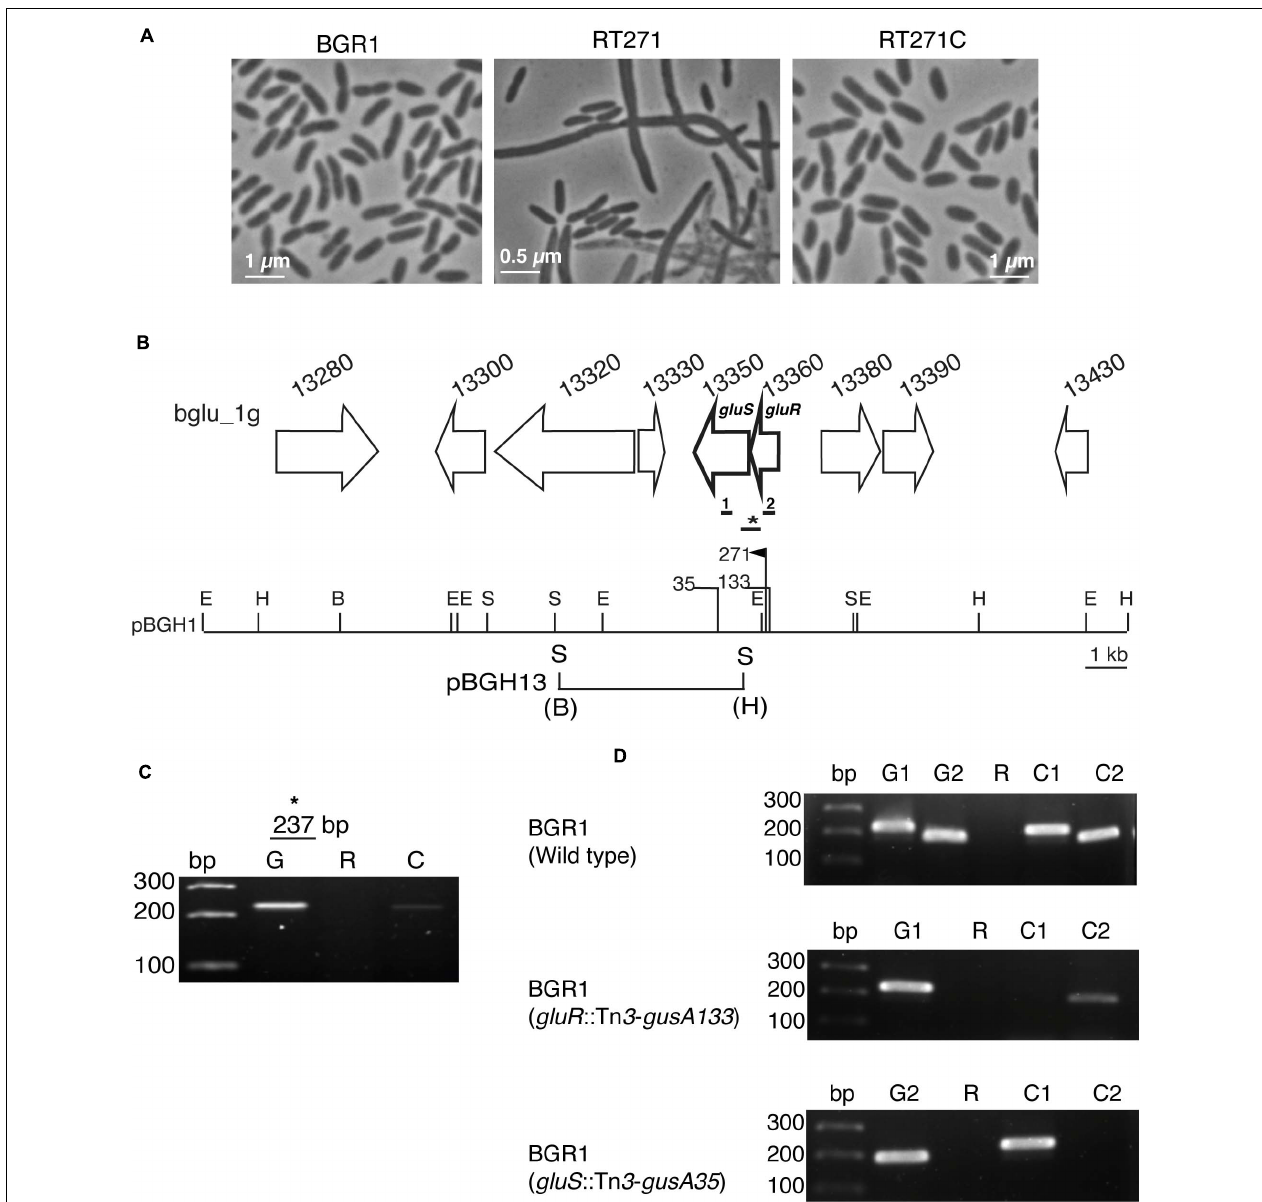
FIGURE 1 | The GluS-GluR two-component system (TCS) of Burkholderia glumae BGR1. (A) Microscopic observation of the cell morphology of BGR1 (wild type), RT271 (BGR1, gluR :mini-Tn 5rescue ), and mutant complemented RT271C (BGR1, gluR :mini-Tn 5rescue carrying pBGH1) strains in Lysogeny Broth (LB) medium. (B) Organization scheme of the GluS sensor kinase and GluR response regulator in pBGH1. Vertical bars above the restriction map indicate the position of the Tn 5 (271) and Tn 3 - gusA insertions (35 and 133). E, Eco RI; H, Hin dIII; B, Bam HI; S, Sac I. The map below pBGH1 represents pBGH13 plasmid of a 6.3-kb fragment containing gluS and gluR genes. (C) RT-PCR analysis showing that gluS and gluR genes are co-transcribed in BGR1. Primers were designed to amplify a 237-bp (*) product encompassing the gluR and gluS genes in the wild type. Lane G, PCR product using genomic DNA as a template; Lane R, PCR product using RNA as a template; Lane C, PCR product using cDNA as a template. (D) No polar effect resulting from Tn 3 - gusA insertion. Lane bp, marker; Lane G1, PCR product from gluR chromosomal DNA as a template; Lane G2, PCR product from gluS chromosomal DNA as a template; Lane R, PCR product from total RNA as a template; Lane C1, PCR product from gluR cDNA as a template; Lane C2, PCR product from gluS cDNA as a template. The thick bars below the gene map indicate the position that was amplified for cDNA synthesis. Primers were designed to amplify 200 bp (1) and 216 bp (2) product of gluS and gluR , respectively. Full gel images are presented in Supplementary Figures 6, 7